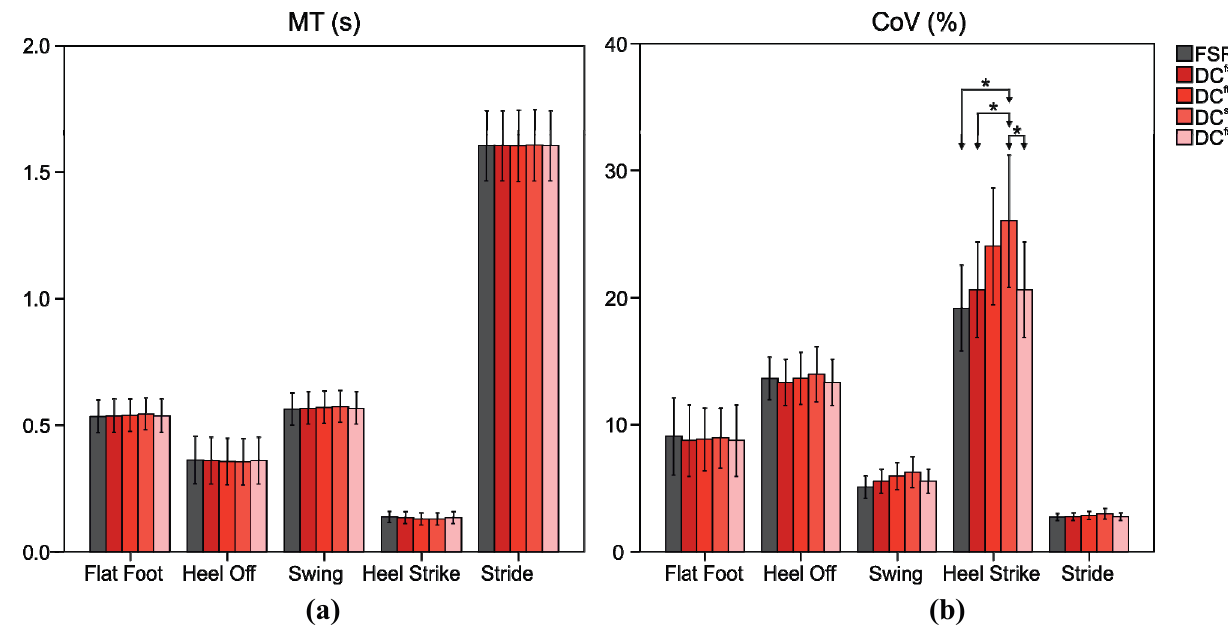
Figure 7. ( a ) Mean Time ( MT ) and ( b ) Coefficient of Variation ( CoV ) evaluated for stride and each gait phase for FSR and DCs. “*” indicates statistically significant